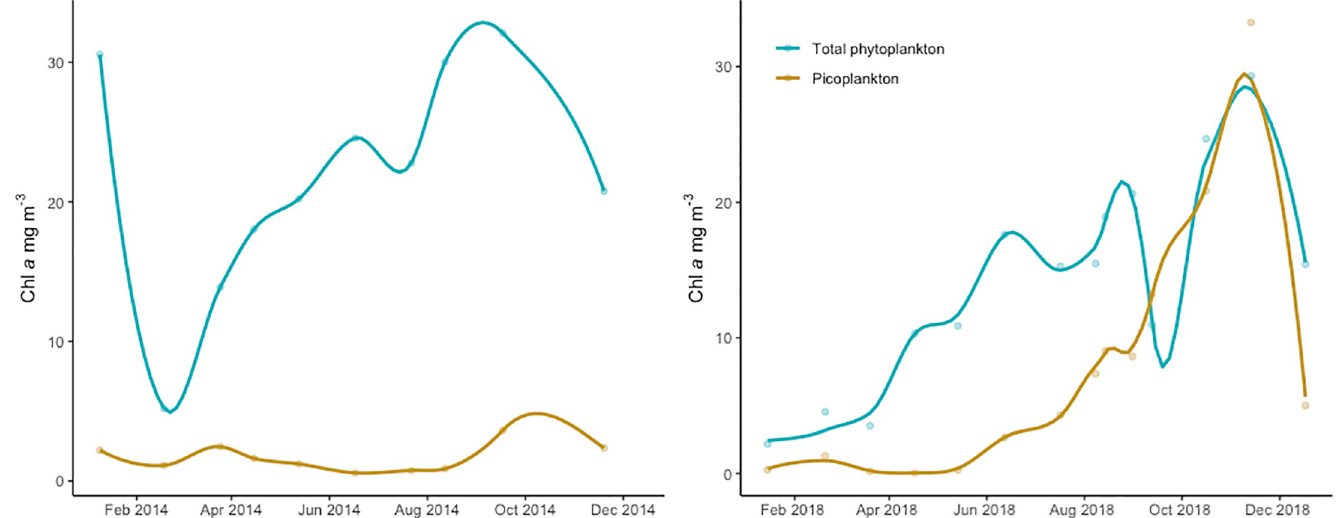
Fig 2. Chl a concentrations of total phytoplankton (GF/F, green) and phototrophic picoplankton (0.2–2 μ m) size fraction (PPP, yellow) in Lake V õ rtsja¨rv during 2014 (left) and 2018 (right). Loess line is fitted on the data.